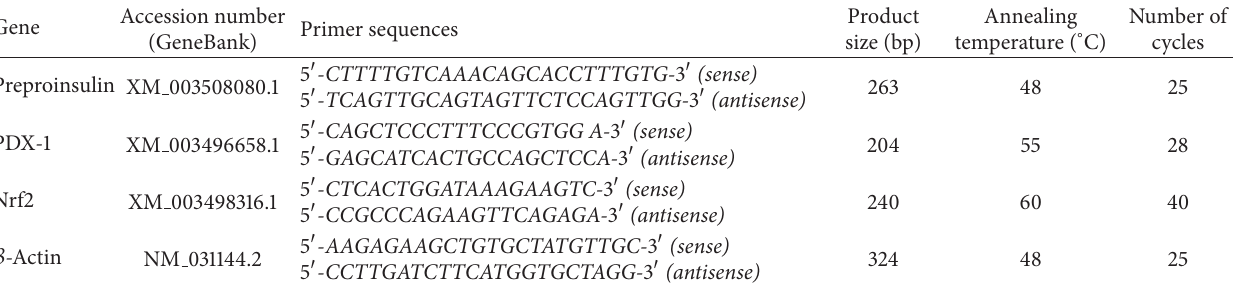
Table 1: DNA sequences of the sense and antisense primers for RT-PCR analysis and cycler conditions.